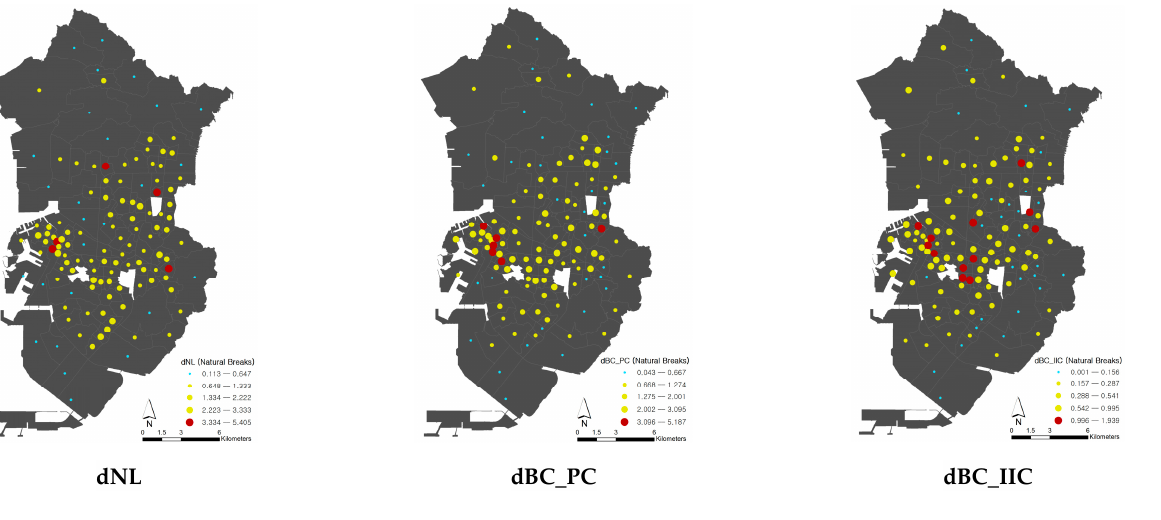
Figure 3. Green Space Connectivity Indexes. Regarding housing characteristics, a large gap was found in housing sales prices, where the maximum value was 690 million won (about $525,000) while the average was approximately 270 million won (about $206,000). This is due to the high housing sales prices of newly developed cities in the outskirt of Incheon (Cheongna and Songdo).